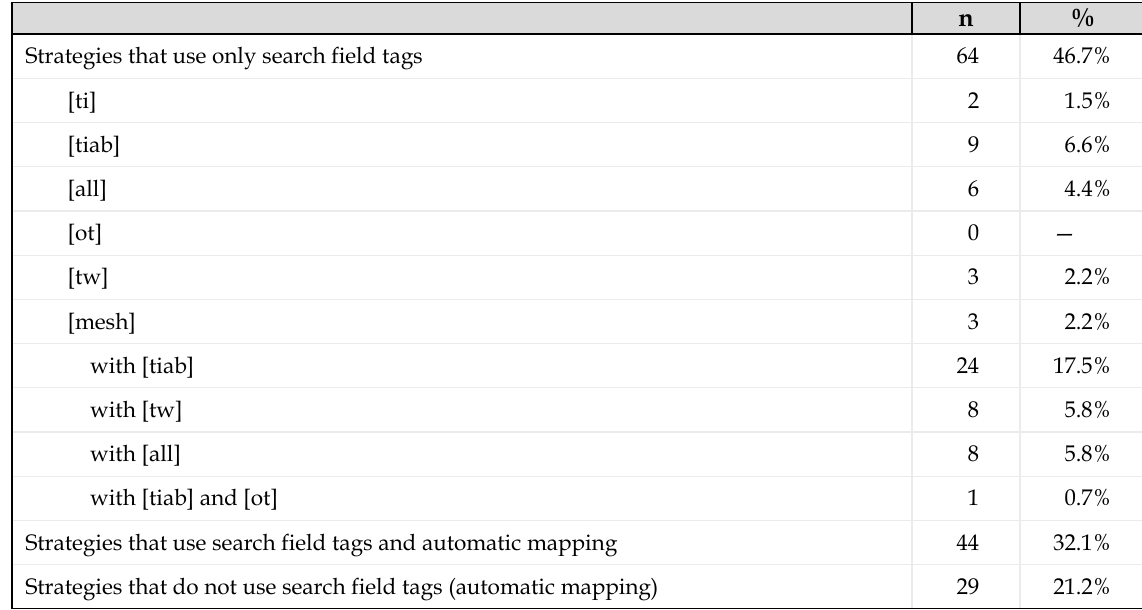
Table 2 Search strategies that use field codes and/or automatic mapping